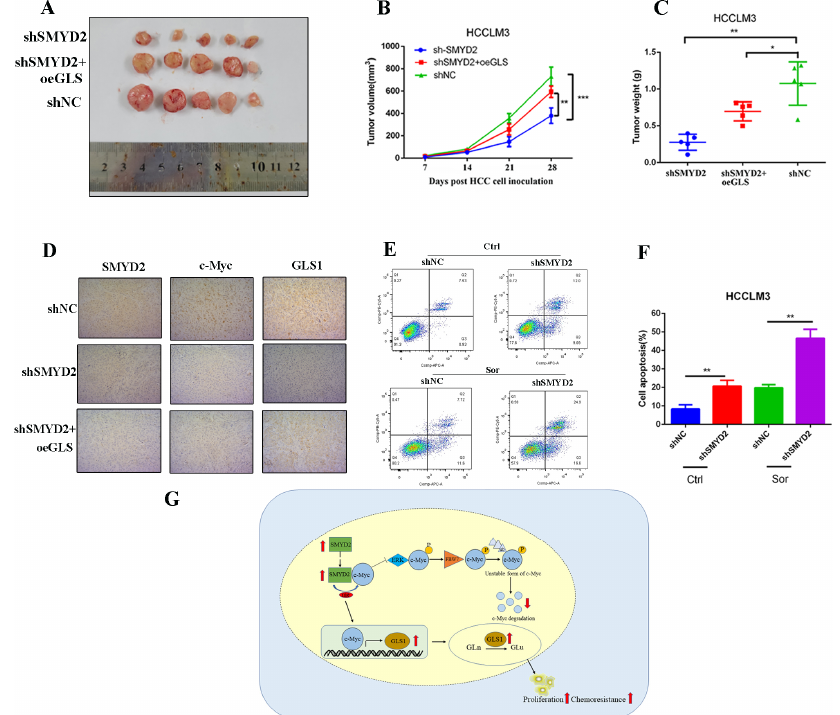
Figure 7. SMYD2 promotes HCC tumor growth and enhances sorafenib chemoresistance in HCC. ( A ) Photographic image of the subcutaneous tumors. ( B , C ) Tumor volumes ( B ) and weight ( C ) were measured. The data are from five mice per group and presented as mean ± SD. The data were ana ‐ lyzed with Student’s t ‐ test. * p < 0.05, ** p < 0.01, *** p < 0.001.( D ) IHC analysis was conducted to examine the expression of SMYD2, c ‐ Myc, and GLS1(scale bar: 100 μ m; magnification: ×200). ( E , F ) Cells were incubated with 5 μ M sorafenib (Sor) for 24 h. Representative images of flow cytometry analysis ( E ) and quantification ( F ) are presented. Data are represented as mean ± SD. ** p < 0.01. The data were analyzed by Student’s t ‐ test. ( G ) Schematic representation shows that SMYD2 upregu ‐ lates GLS1 expression through the SMYD2/c ‐ Myc cascade, thereby regulating glutamine metabo ‐ lism and promoting HCC growth. Abbreviations: Gln, glutamine; Glu, glutamate.